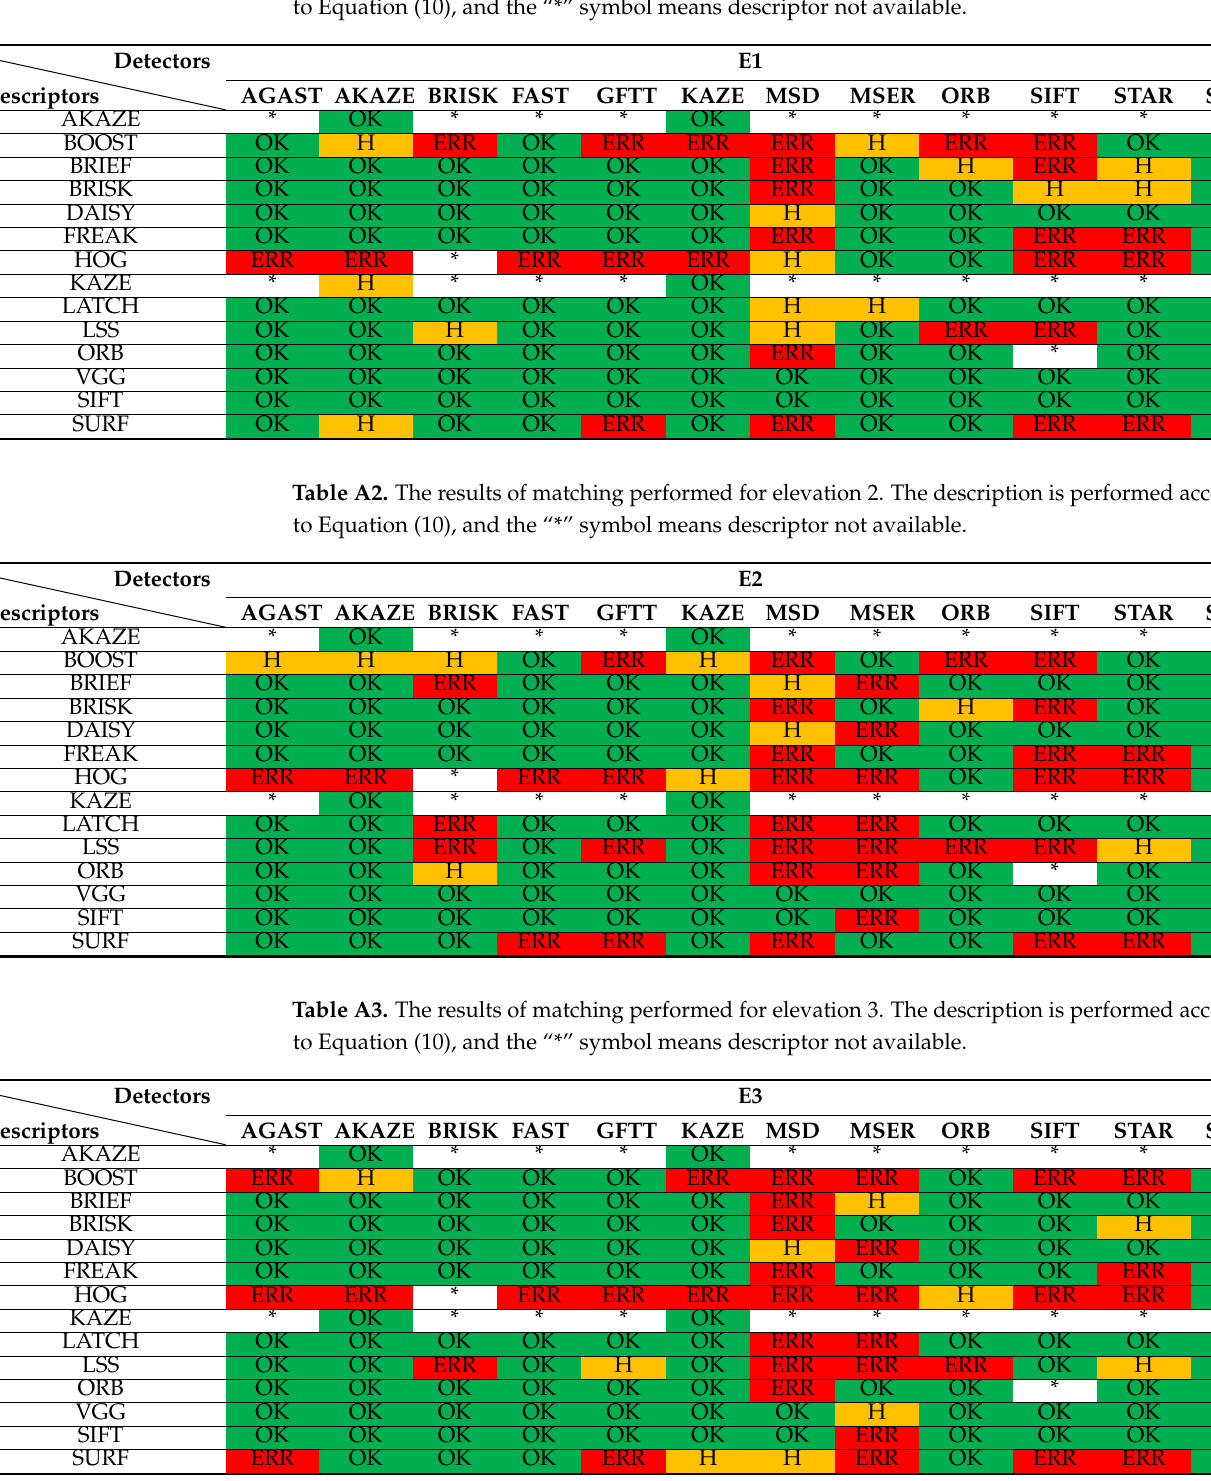
Table A1. The results of matching performed for elevation 1. The description is performed according to Equation (10), and the “*” symbol means descriptor not available.